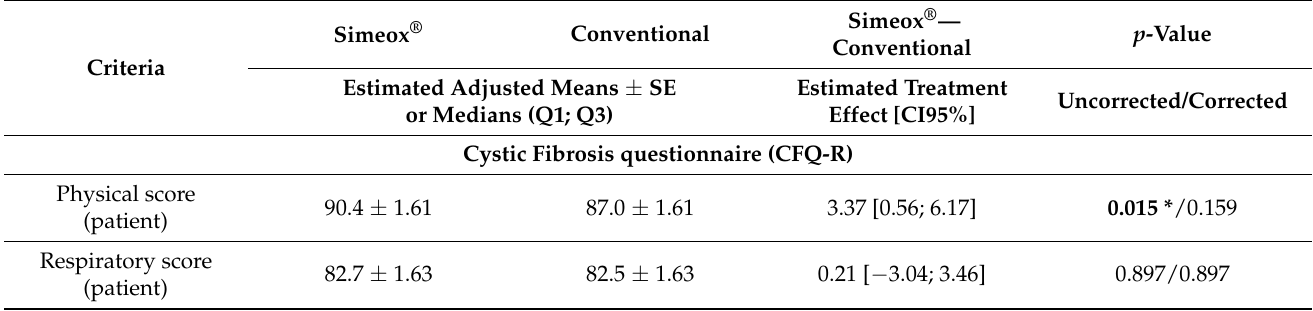
Table 4. Comparisons of treatment effects on CFQ-R (estimated mean after one month of intervention).